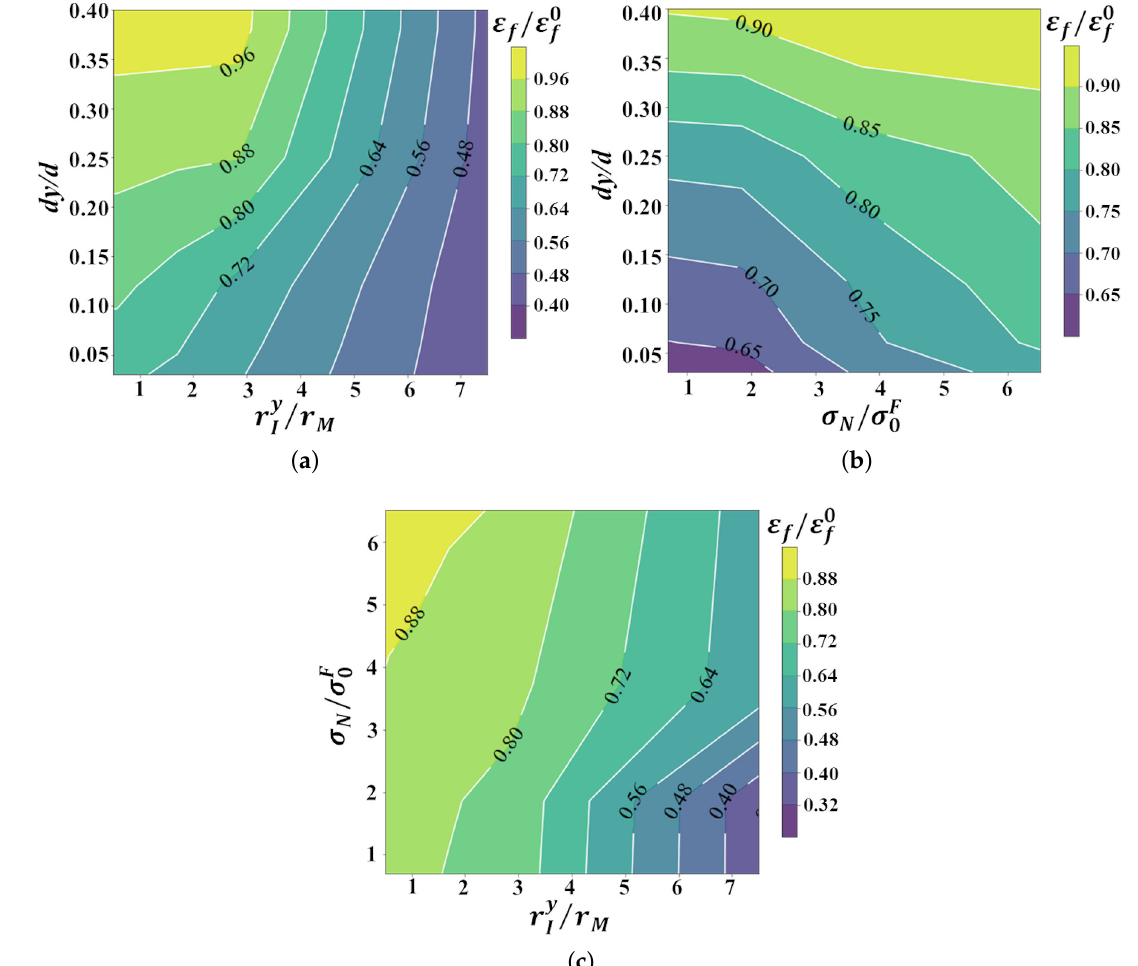
Figure 12. Partial dependence plots showing the effects of ( a ) normalized location, dy / d , and size, r y location, dy / d , and strength, σ N / σ F i.e., the normalized macroscopic flexural strain to failure, ε f / ε 0